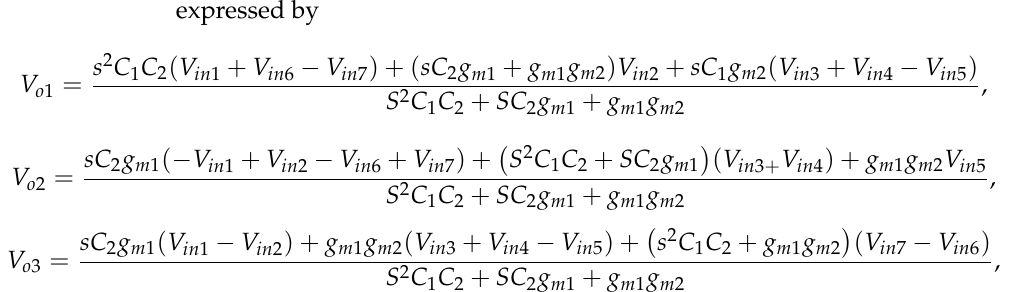
Figure 4. Proposed voltage-mode analog filter. Using (1), (2) and nodal analysis, the output voltages of the circuit in Figure 4 can